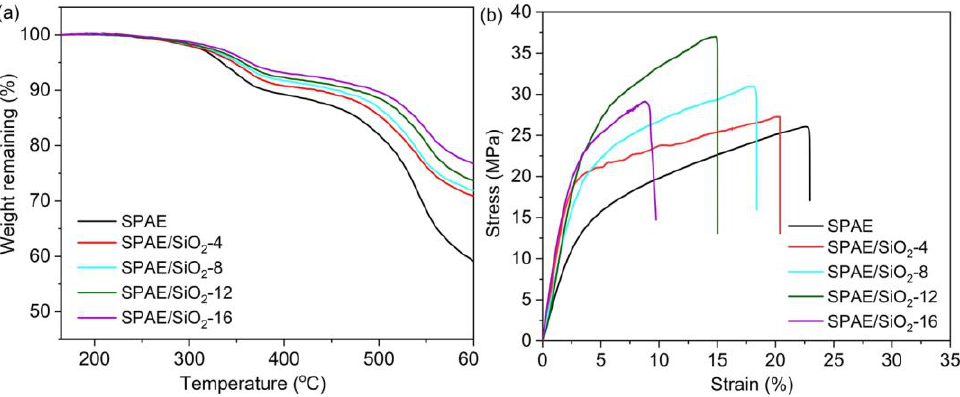
Figure 5. ( a ) TGA curves and ( b ) strain – stress curves of the SPAE and SPAE/SiO 2 composite PEMs. The mechanical strength of PEMs is critically important for practical